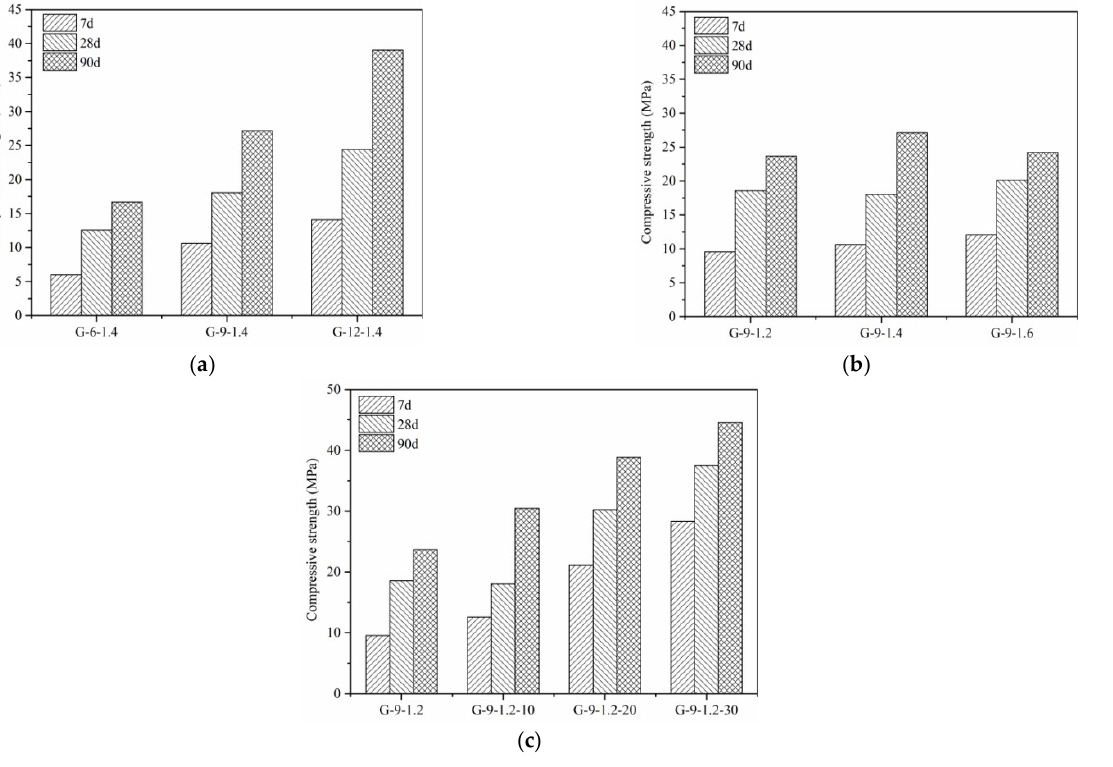
Figure 3. Effects of different factors on the compressive strength of FA-based geopolymers: ( a ) content of Na 2 O; ( b ) M s ; ( c ) content of